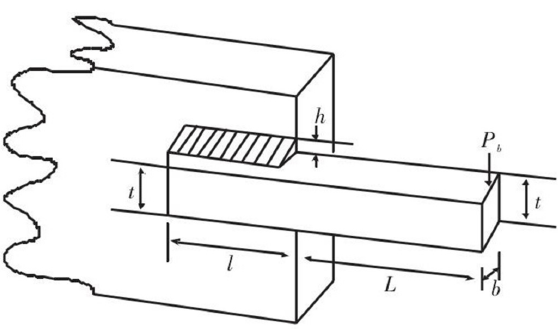
Figure 7. Design principle of the welded beam. Table 10. Comparison of welded beam